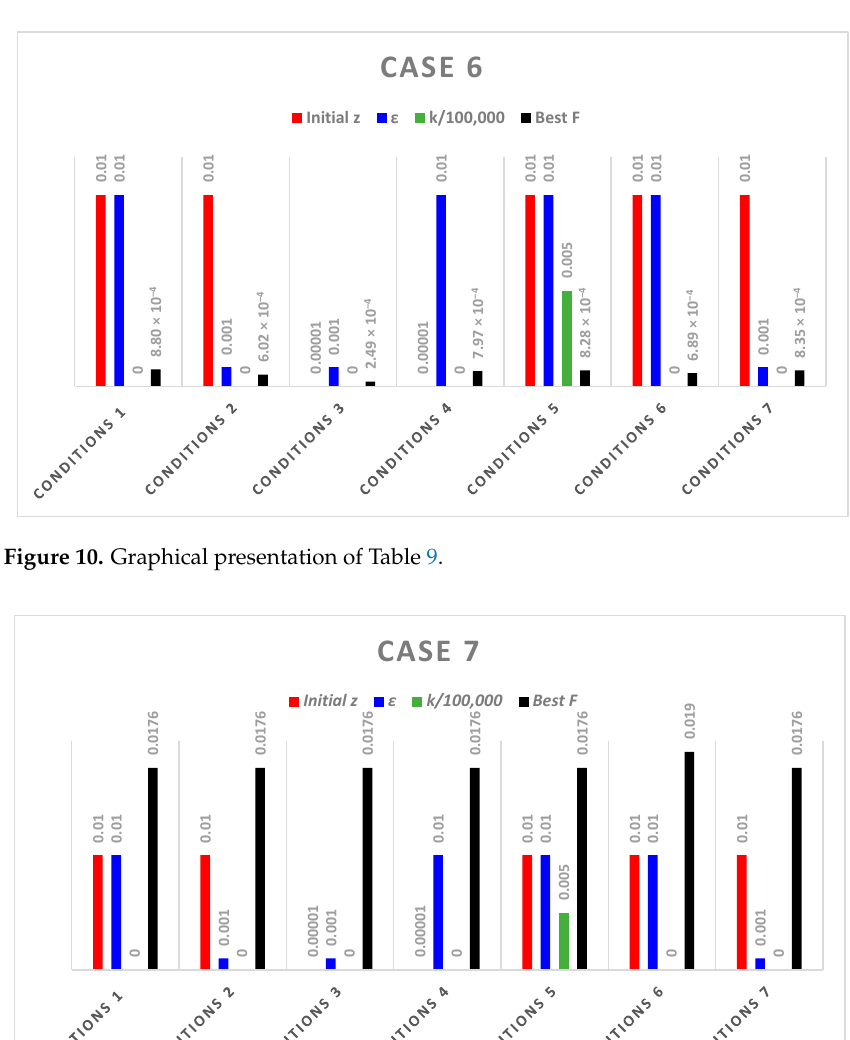
Figure 9. Graphical presentation of Table 8.